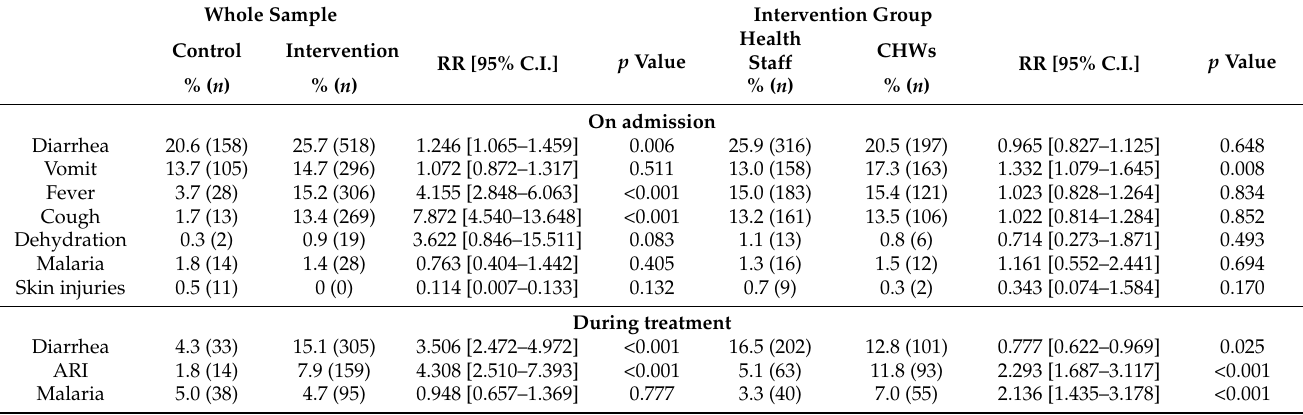
Table 6. Cases of diseases detected and treated in an integrated manner with the severe acute malnutrition. Whole